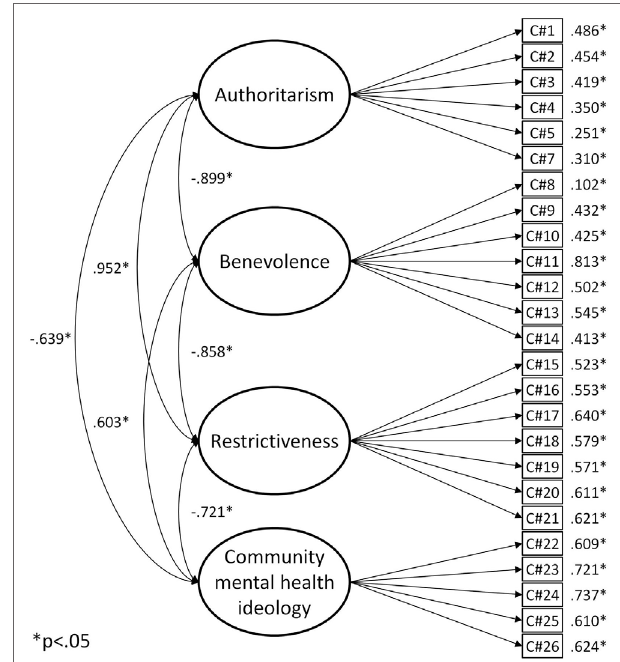
FigUre 1 | CAMI modified four-factor